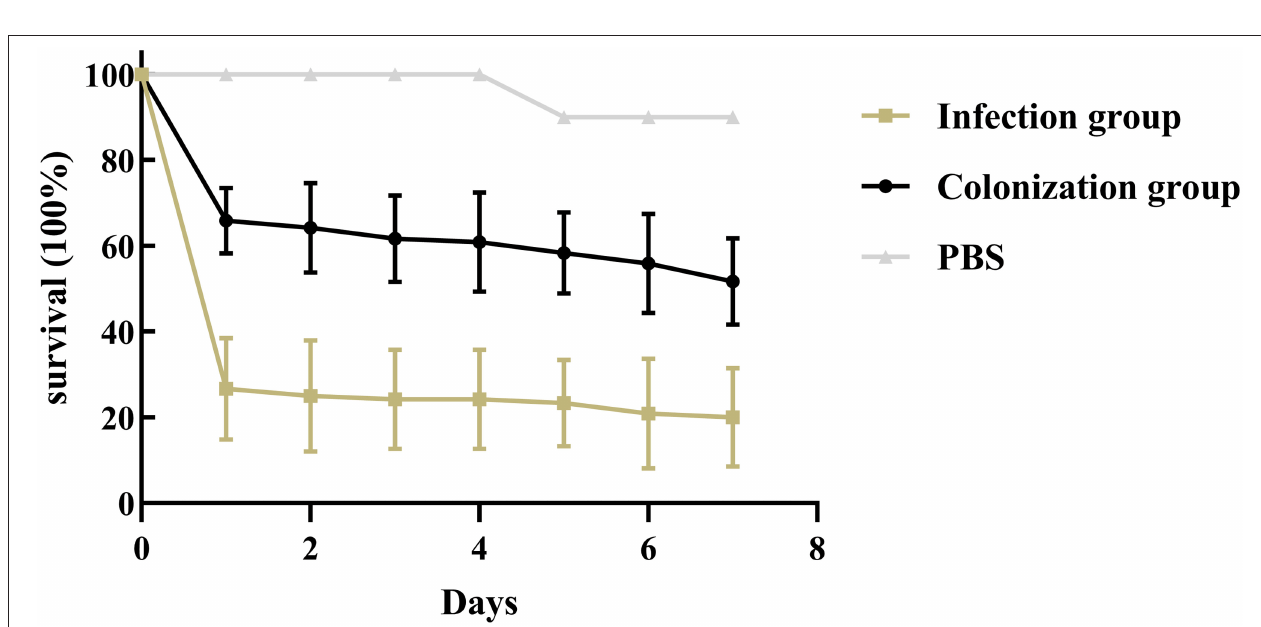
FIGURE 5 | Infection model of Galleria mellonella larvae. Survival of Galleria mellonella larvae infected by intestinal CRKP strains.